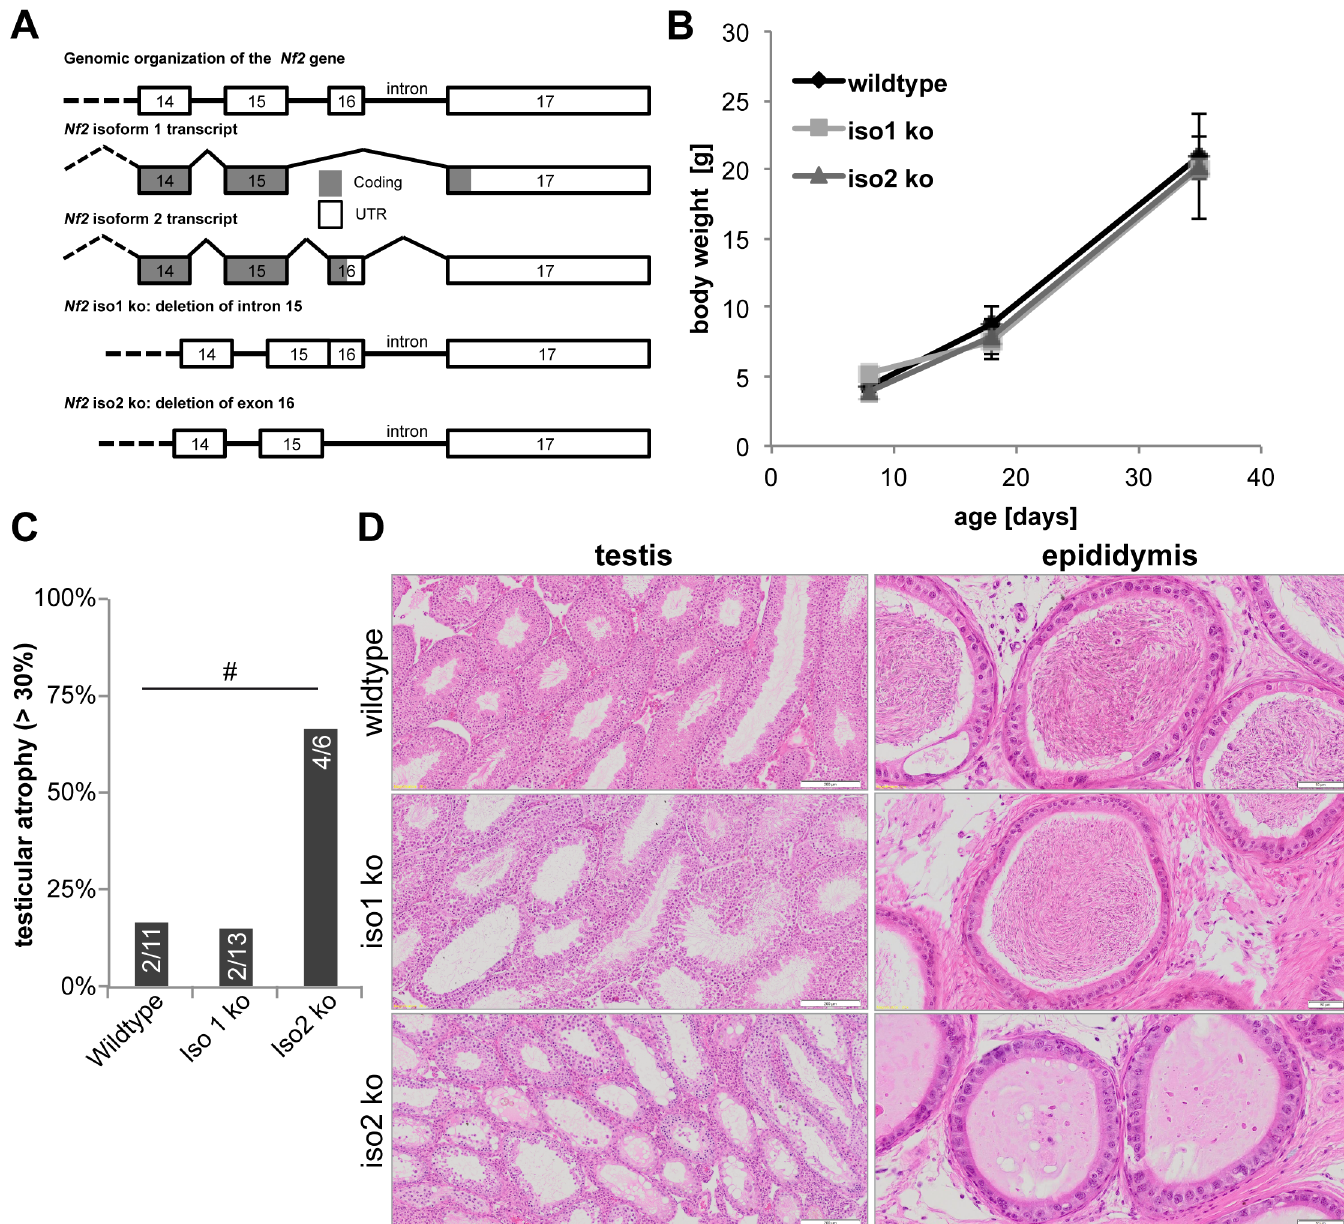
Fig 2. Knockout of Nf2 isoform 2 causes testicular atrophy in aged mice. (A) Organization of the Nf2 gene locus, splicing of isoform 1 and gene knockout strategy. Note that deletion of one isoform causes expression of the other. (B) Body weight of iso1 ko and iso2 ko animals. Development of mice was normal (n = 3 for each genotype and time point). (C) Percentage of aged (22 – 26 months old) animals displaying testicular atrophy in more than 30% of tubules. #: significant on an a α -level of < 0.1 (Fisher ’ s exact test). (D) H&E-stained tissue sections showing testicular atrophy and empty epididymis of iso2 ko animals. Scale bar = 200 μ m (testis)/ 50 μ m